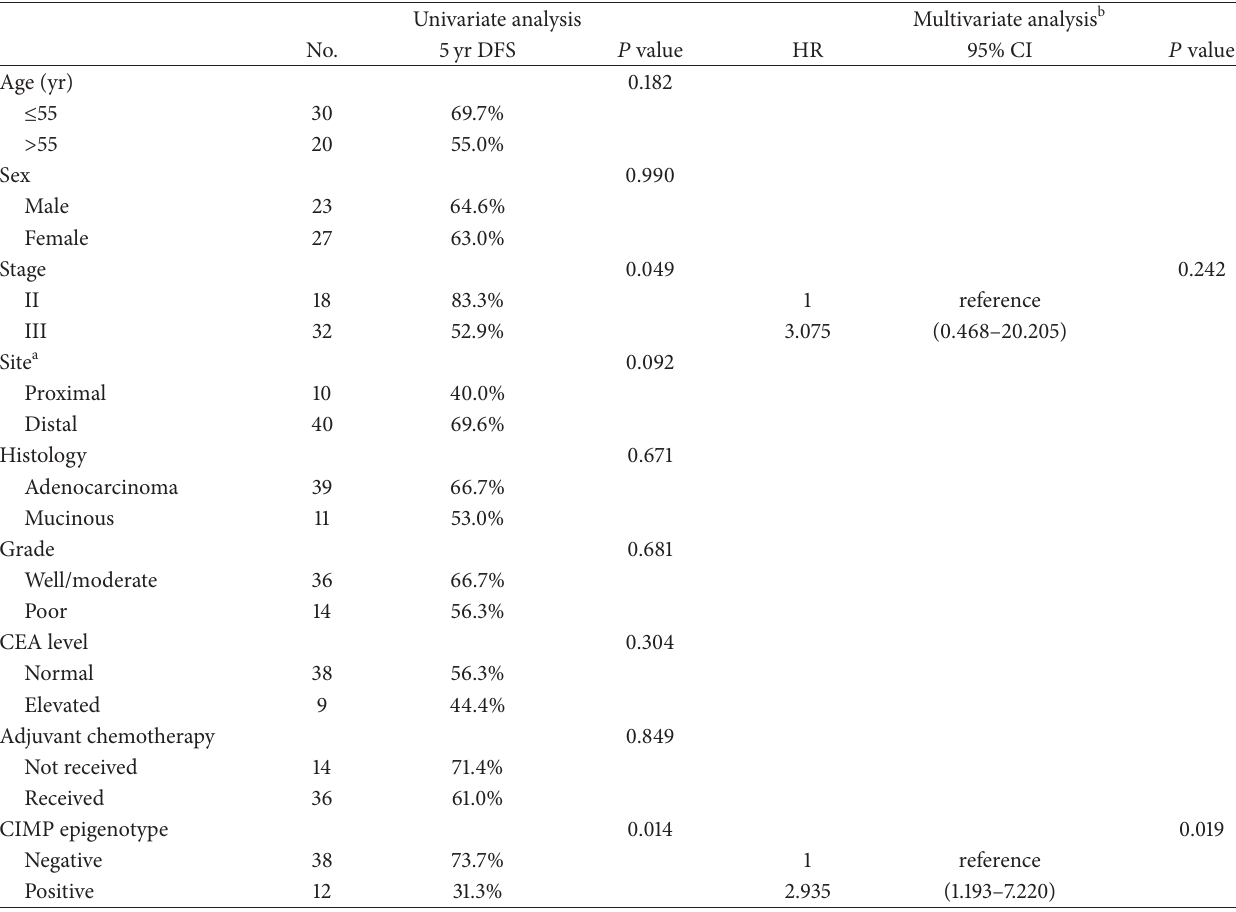
Table 2: Univariate and multivariate analysis of the prognostic effect of CIMP status and clinicopathological features in stage II/III cases for